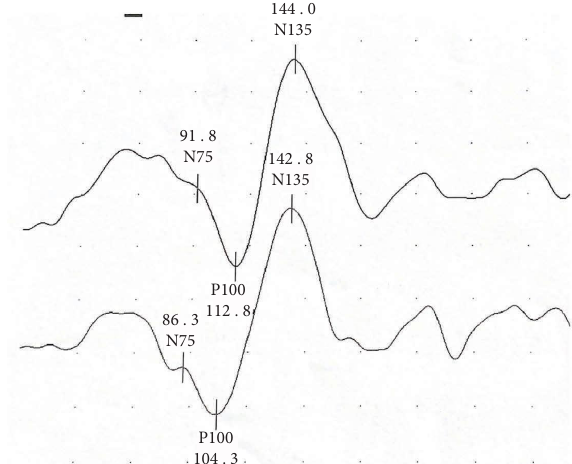
Figure 1: A waveform sample from PD group. VEP amplitude, N75, N135, and P100 latencies for the right and left eyes were measured. Te upper waveform was obtained from the right eye and the lower waveform was obtained from the left eye. (Latencies are given in milliseconds (ms) and amplitudes in microvolts ( μ V). Between two points in the vertical direction represent 2 μ V, peak- to-peak amplitude of the P wave are 7.66 μ V on the upper wave and 7.33 μ V on the lower wave, respectively).